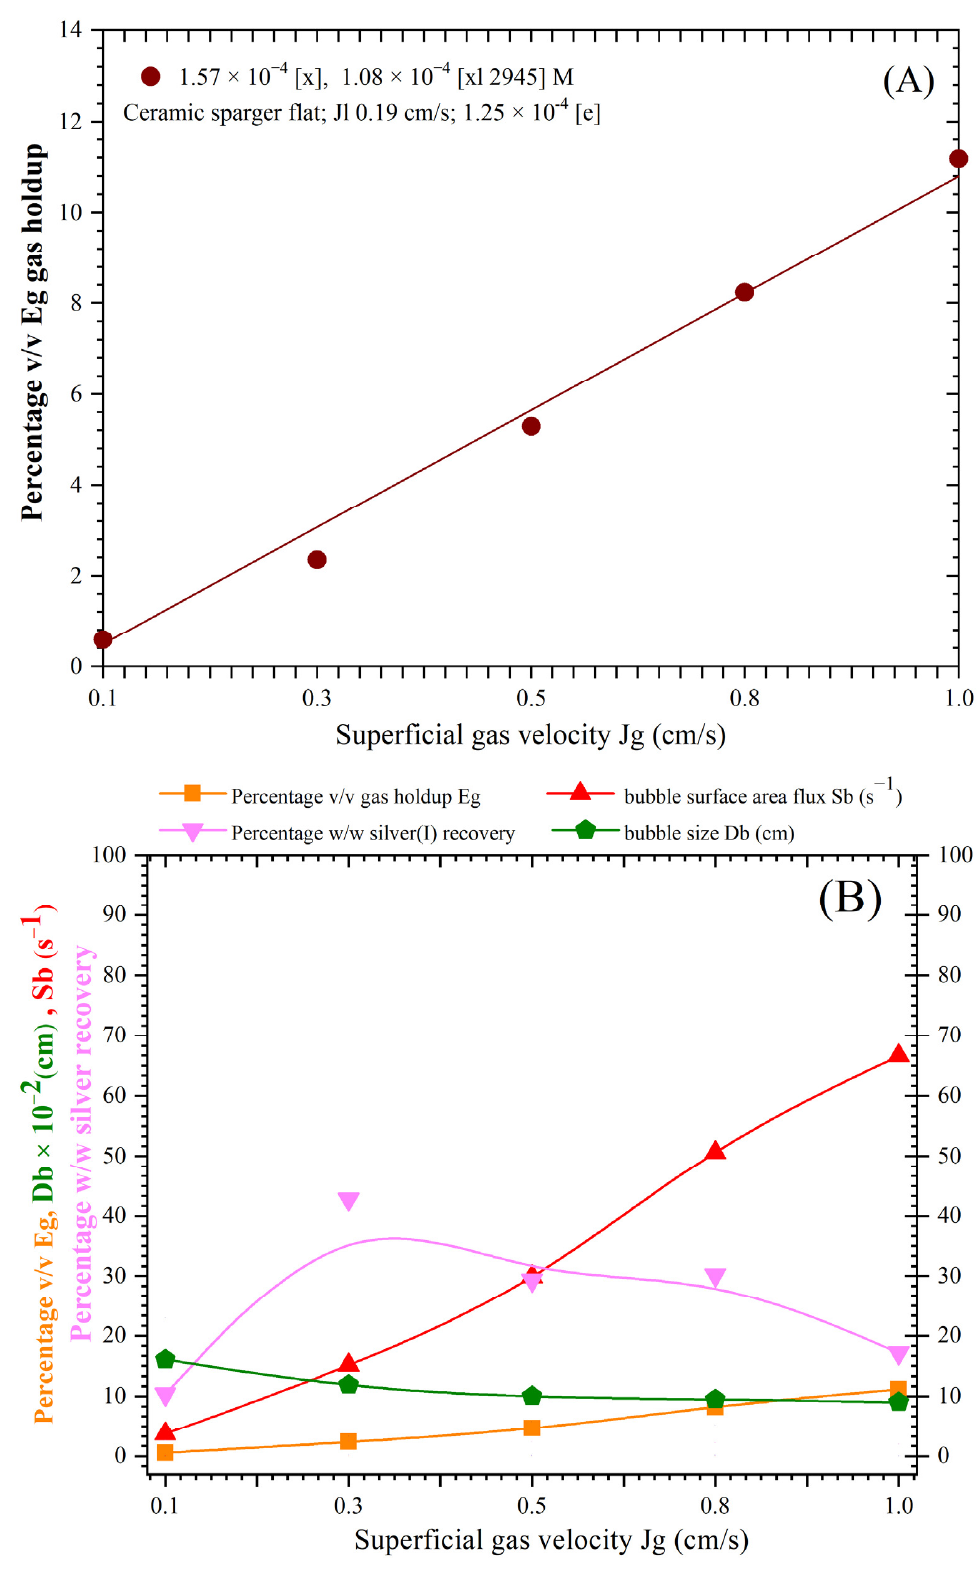
Figure 12. ( A ) Percentage of v / v gas holdup as function of Jg (cm/s). ( B ) Eg, Db, Sb, percentage of w / w of silver(I) ion flotation vs. Jg, ceramic sparger, Jl 0.19 cm/s, and 0.82 × 10 − 4 M [xl245]–1.08 × 10 − 4 M [xl2945].